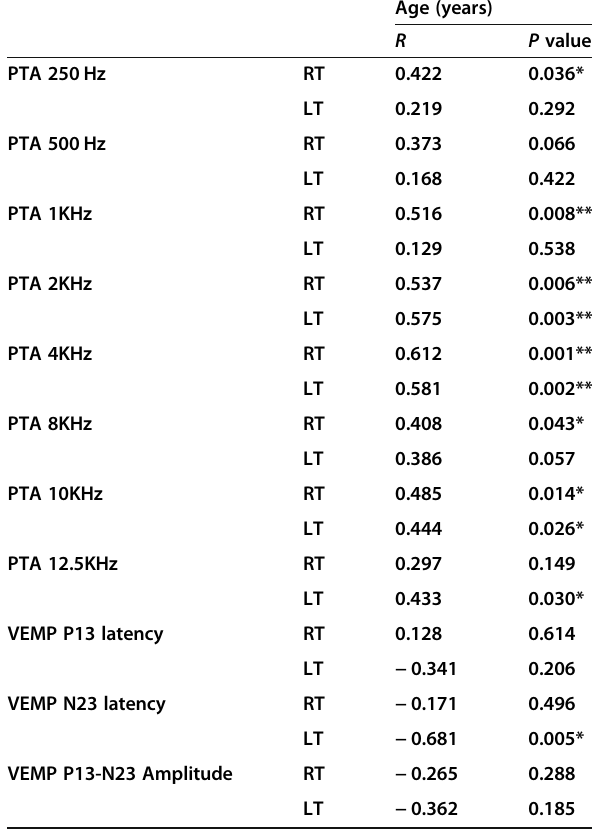
Table 4 Correlation between age of BD with PTA and VEMP